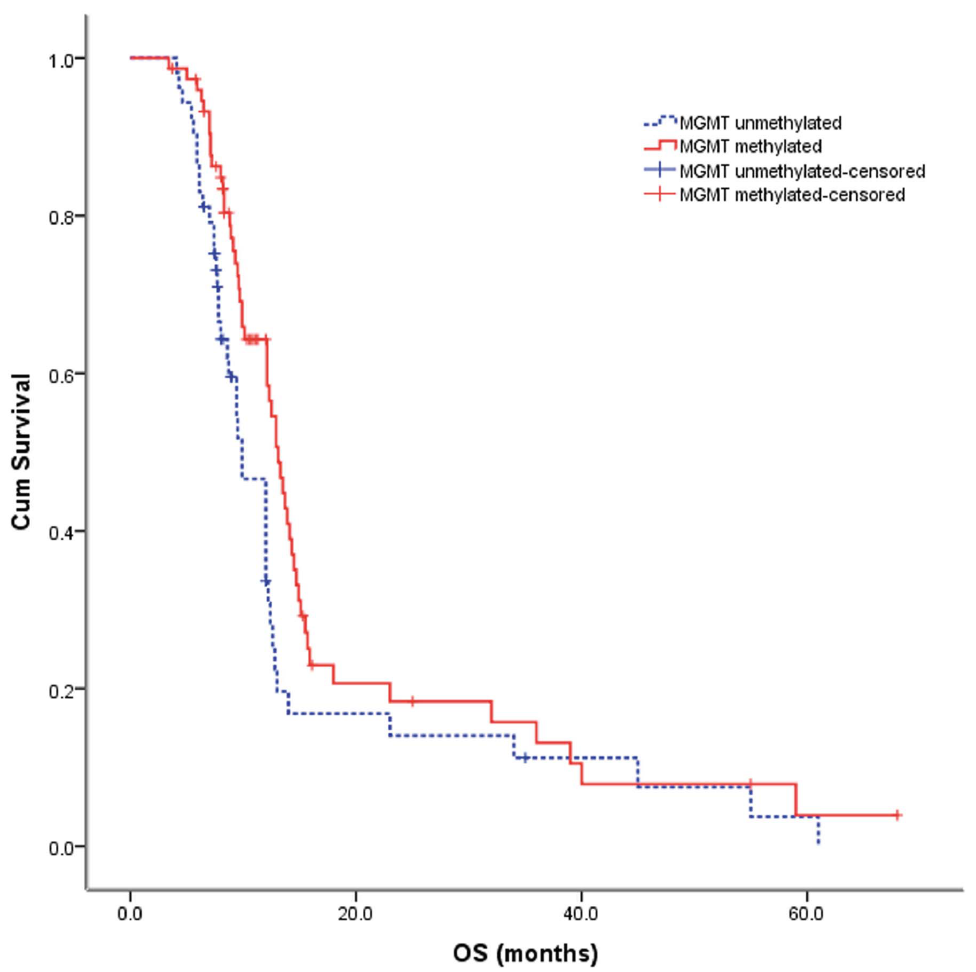
Figure 2. OS after treatment in patients with methylated and unmethylated MGMT promoter glioblastomas (log-rank P=0.029).